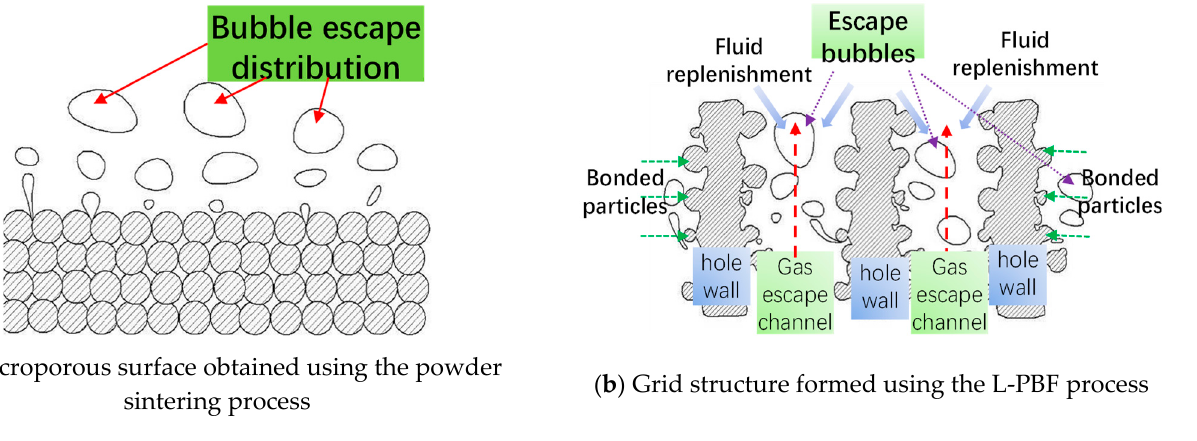
Figure 12. Enhancement of the boiling heat transfer process due to the microporous structures.